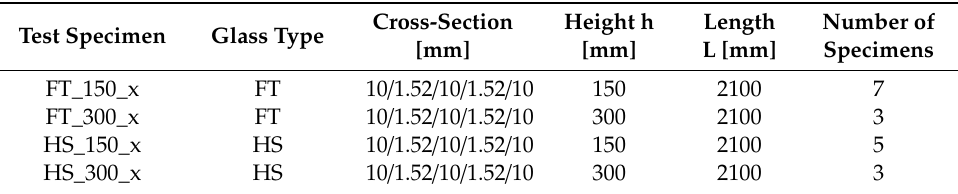
Table 1. Overview of the test specimens.